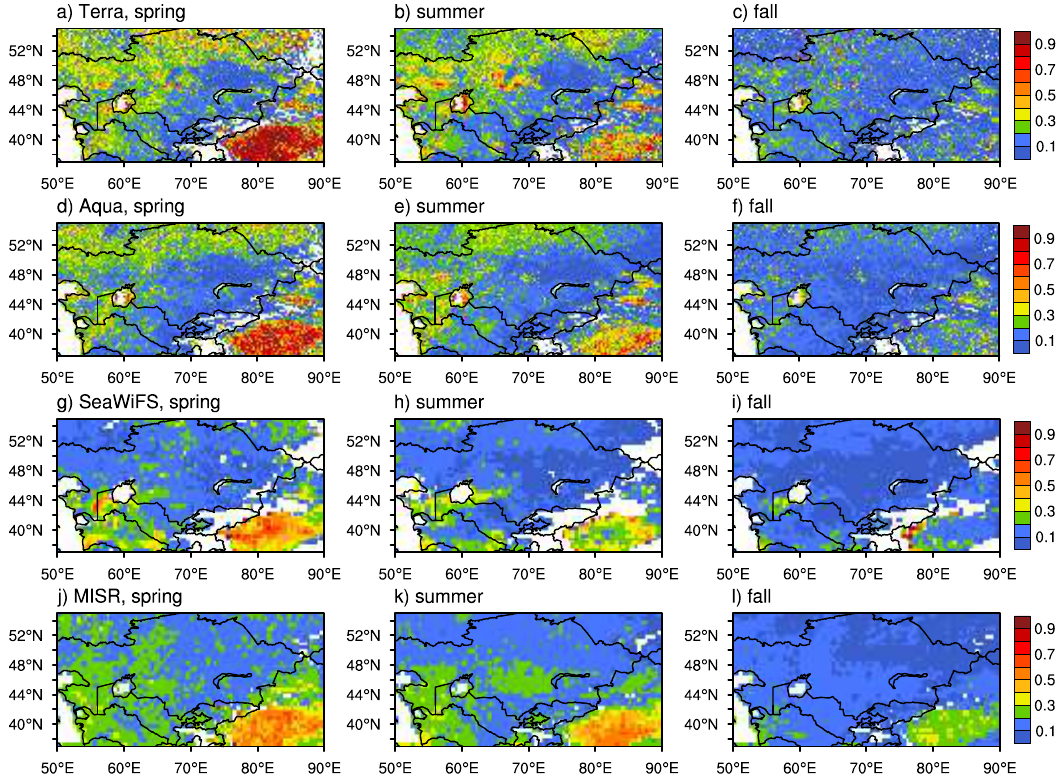
Figure 2. Seasonal distribution of AOD (unitless) from MODIS onboard the Terra ( a , b , and c ) and Aqua ( d , e , and f ) satellites, SeaWiFS ( g , h , and i ), and from MISR ( j , k , and l ) for MAM, JJA, and SON of the 2003–2007 period.